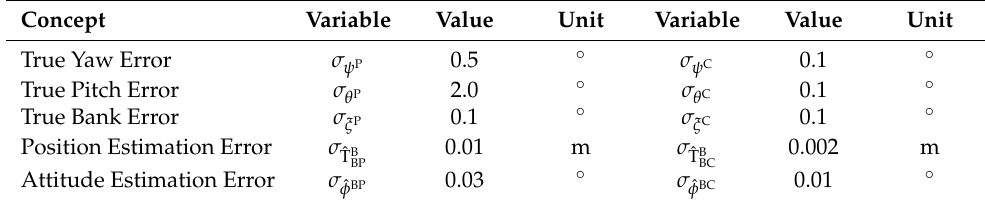
Table 19. Example for IMU and camera mounting accuracy